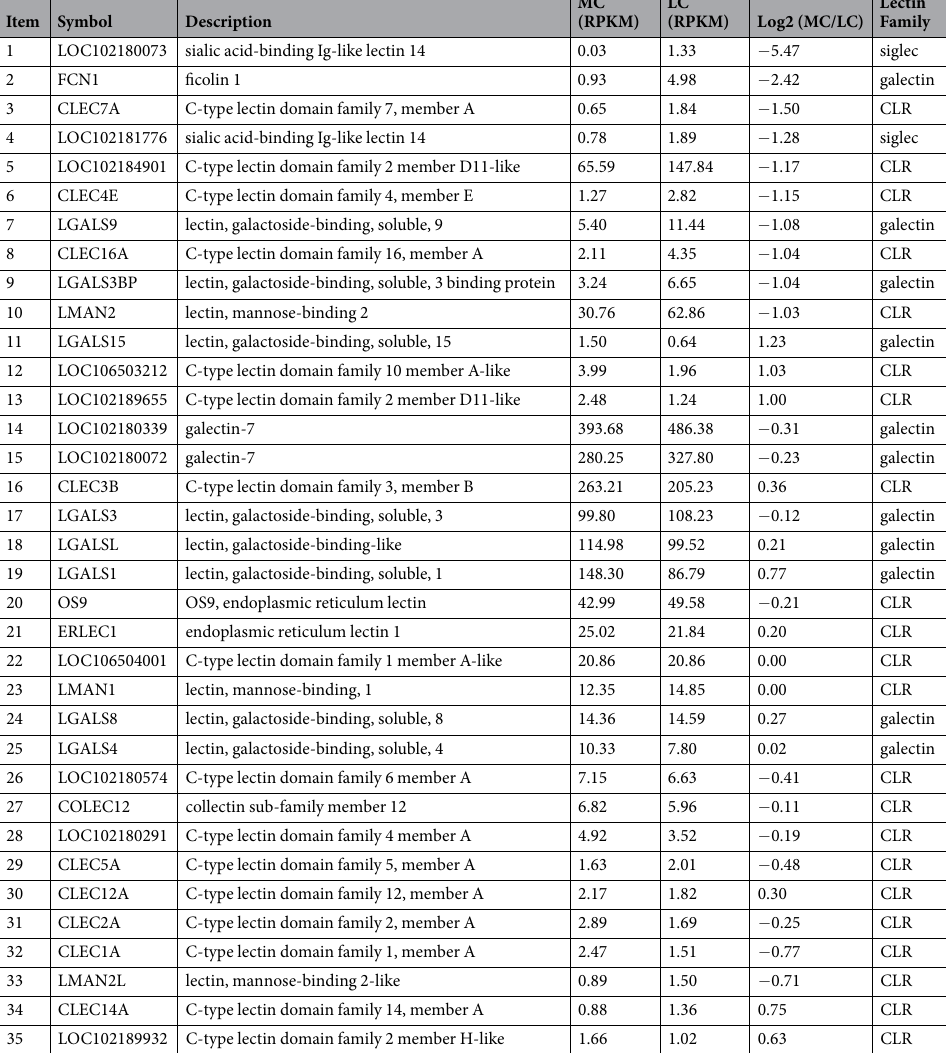
Table 1. Members of the lectin families expressed and observed in the present